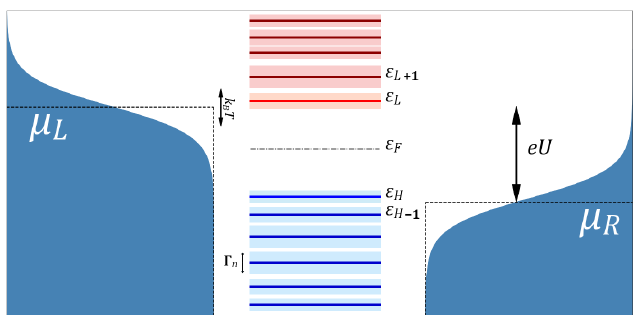
Figure 1. Schematic picture of the broadened energy levels of the molecule and the Fermi distributions in the